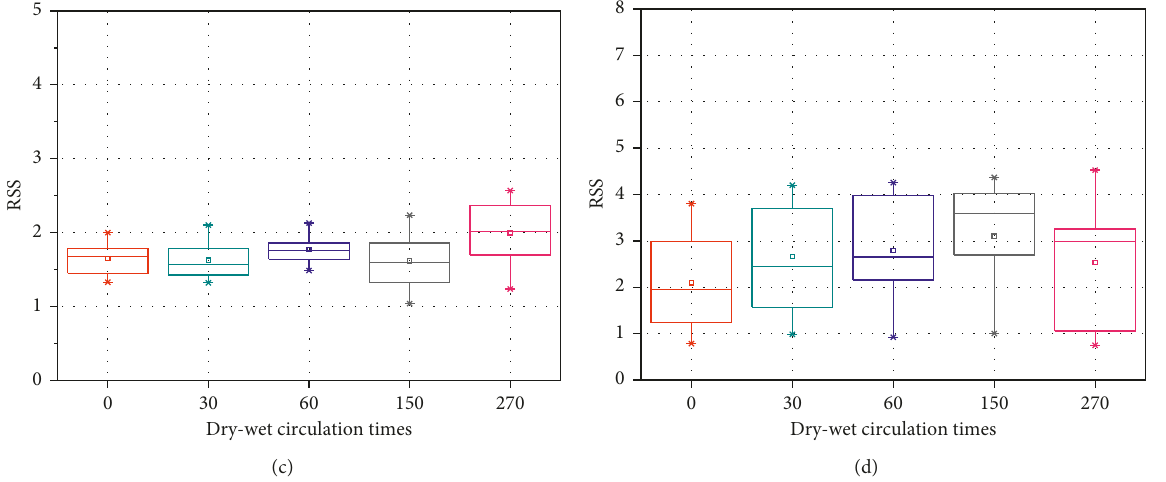
Figure 6: Percentile box figure with the analysis index of RSS for (a) the double exponential model, (b) the Weibull model, (c) the first-order process, and (d) the zero-order process.